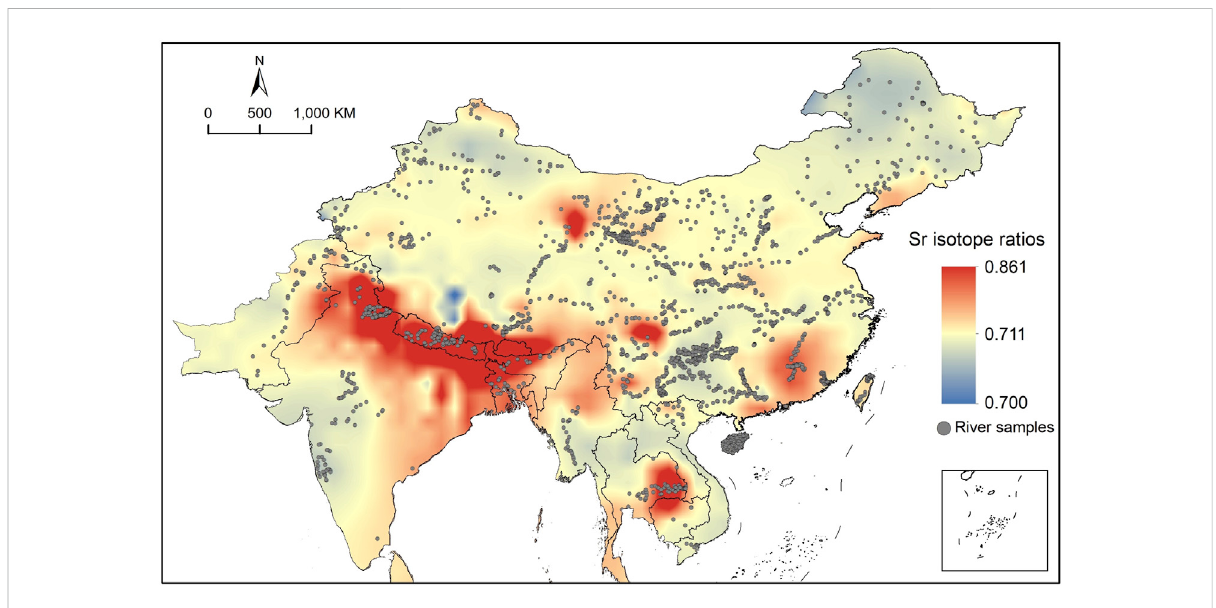
FIGURE 3 The updated bioavailable strontium isoscape for China and its neighbouring area. The dataset consists of 3,158 water samples, and details can be available from the Supplementary